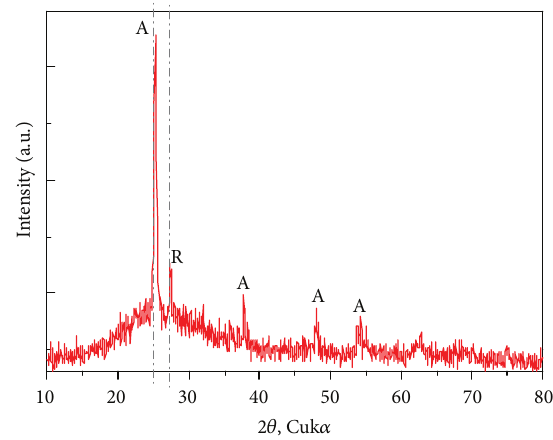
Figure 1: XRD pattern of the TiO 2 immobilized particles on glass plate (A: anatase; R: